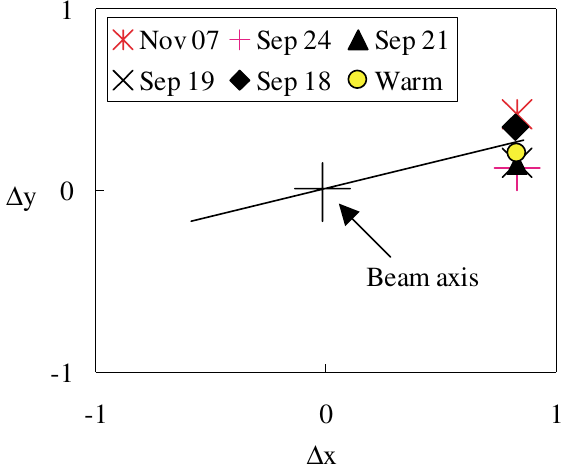
FIG. 12. (Color) Normalized position of the deflected beam in the x - y